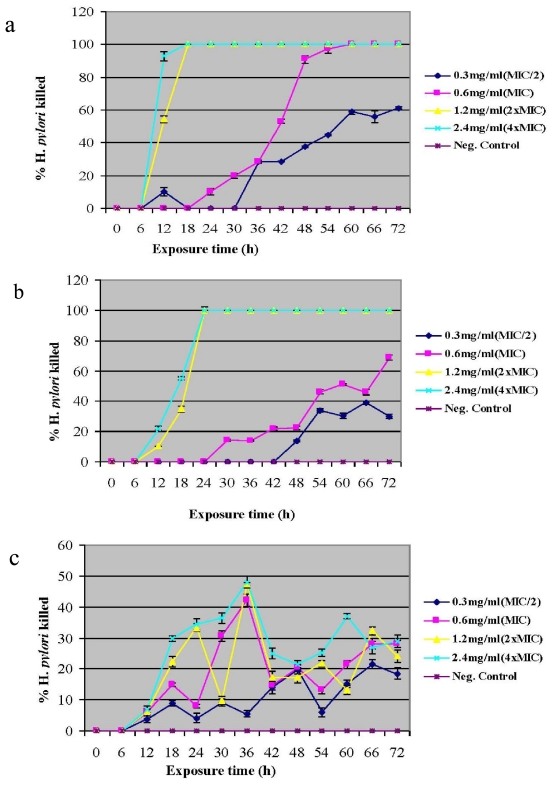
(a) Rate of killing of H. pylori by the acetone extract of S. birrea; (b) Rate of killing of H. pylori by the acetone extract of C. molle; (c) Rate of killing of H. pylori by the aqueous extract of S. birrea. Percentage of H. pylori killed represents mean values of triplicate determinations for the strains PE2A, PE14C and PE93A. Error bars represent the standard deviation (SD). Very small error bars have been obscured by data symbols. Neg. Control, extract-free cells.